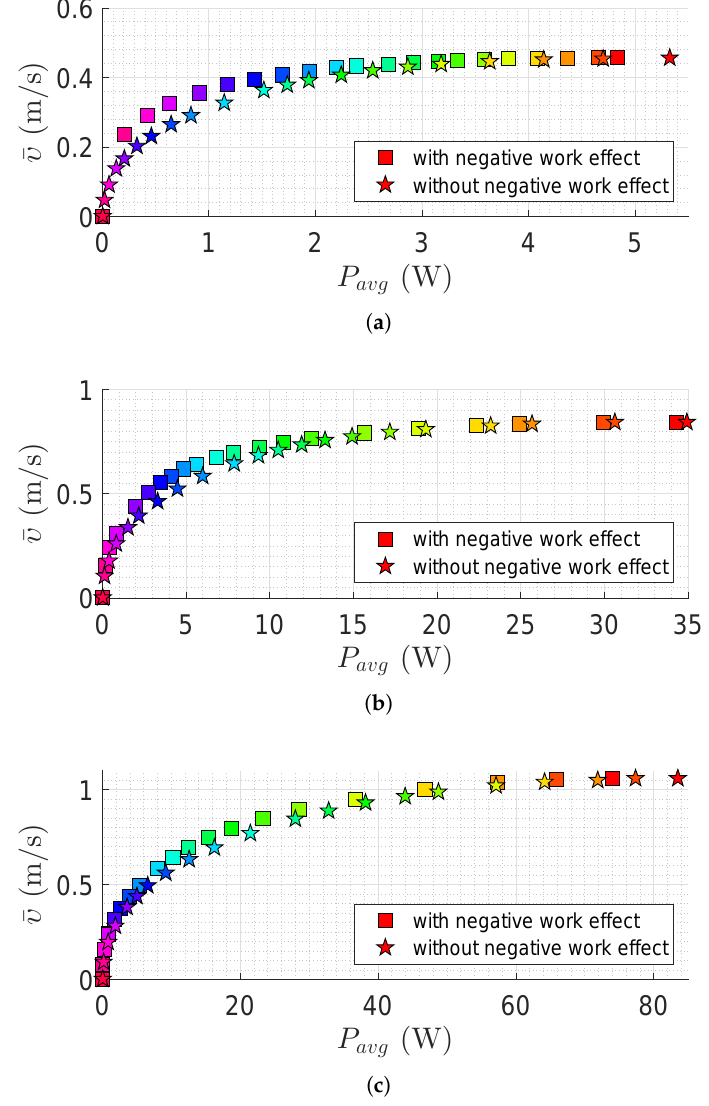
Figure 4. Pareto front for the USR using the lateral undulation motion pattern: ( a ) Pareto front for robot with n = 5 links; ( b ) Pareto front for robot with n = 10 links; and ( c ) Pareto front for robot with n = 20 links. Colors illustrate different weights of the objective